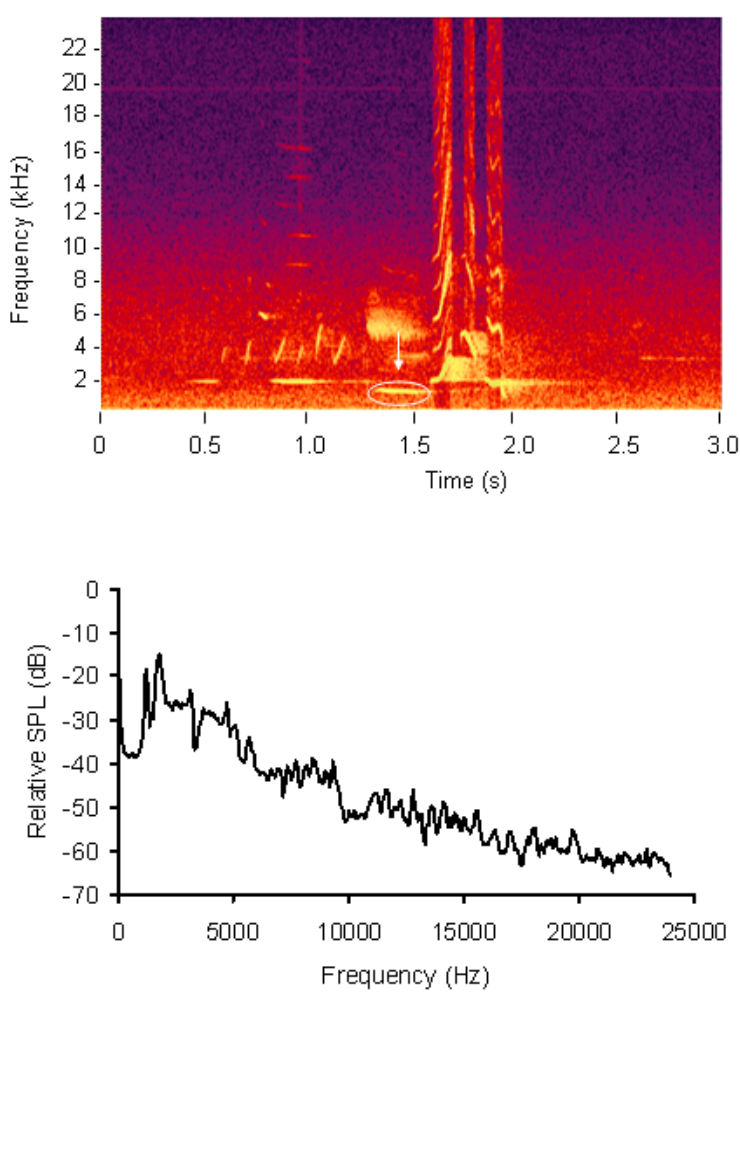
Fig. 1. Sonogram and power spectrum of a song of the Grey Shrike-thrush ( Colluricincla harmonica ), produced using Adobe Audition 2.0. The lowest tonal note is indicated with a circle and an